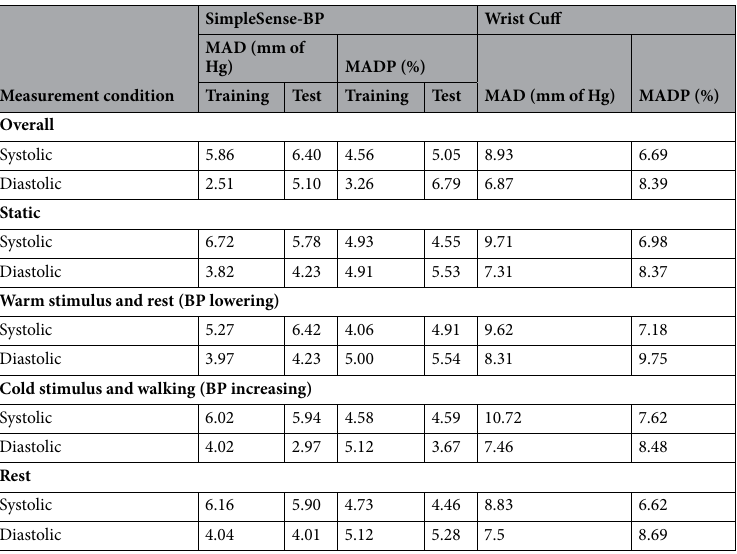
Table 3. Performance evaluation of Blood pressures measured by SimpleSense and a wrist cuff